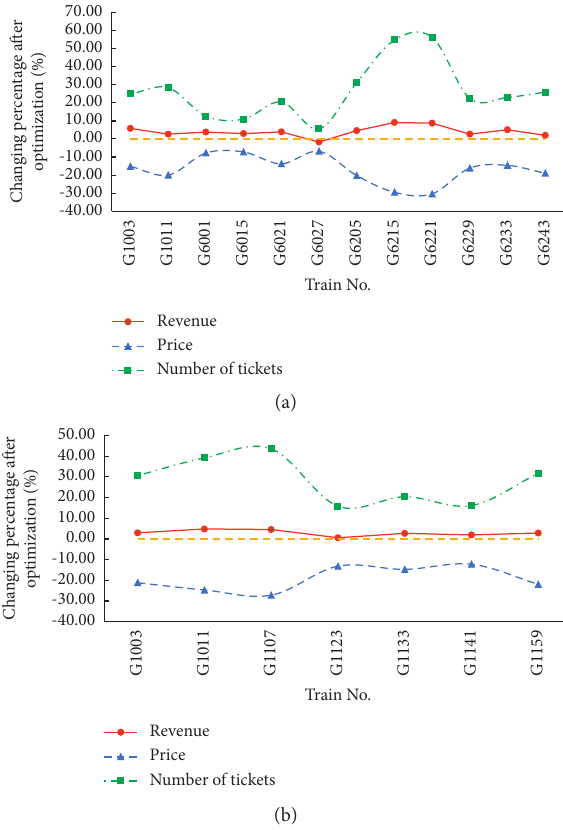
Figure 12: (a) Index variation of products in GZS-SZN. (b) Index variation of products in